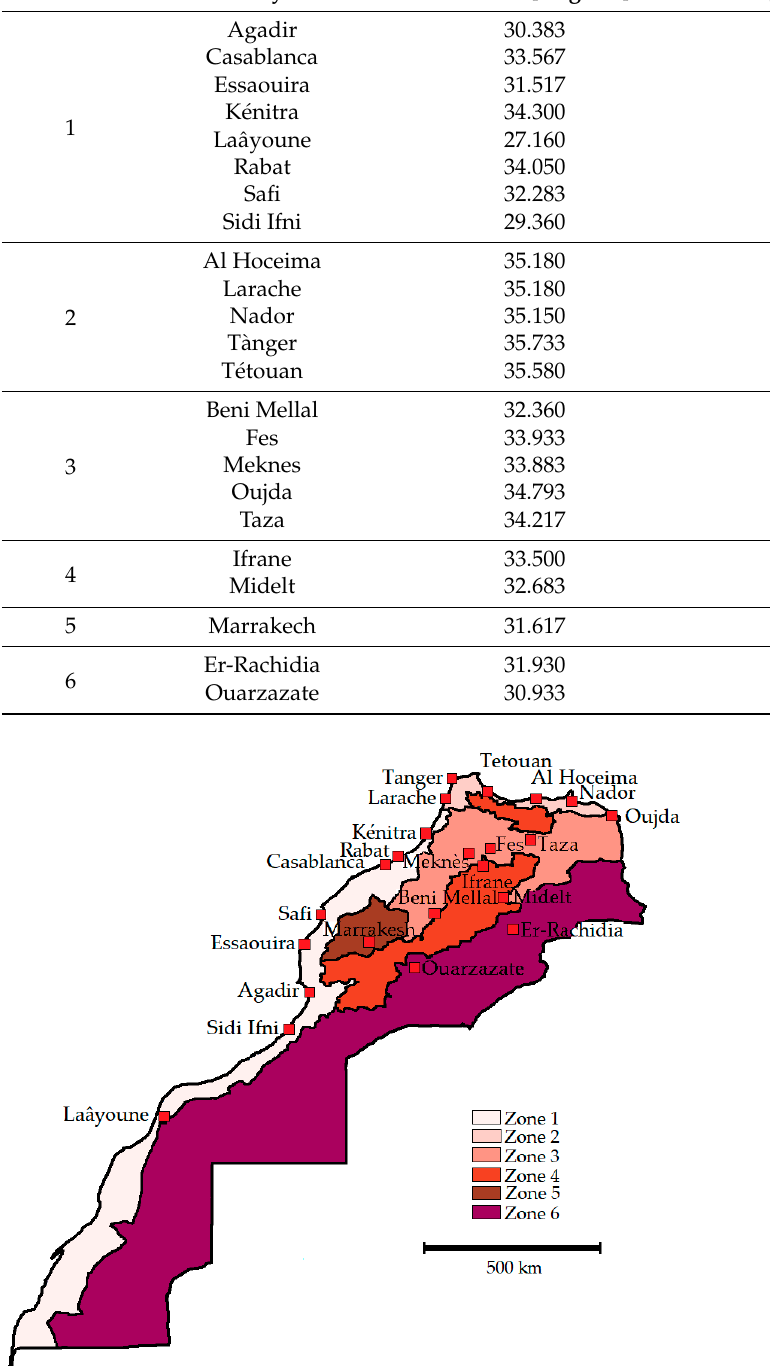
Figure 4. Climatic zones of Morocco. Source: own elaboration based on [57] . Measured solar irradiation data at ground level are not available for all cities and